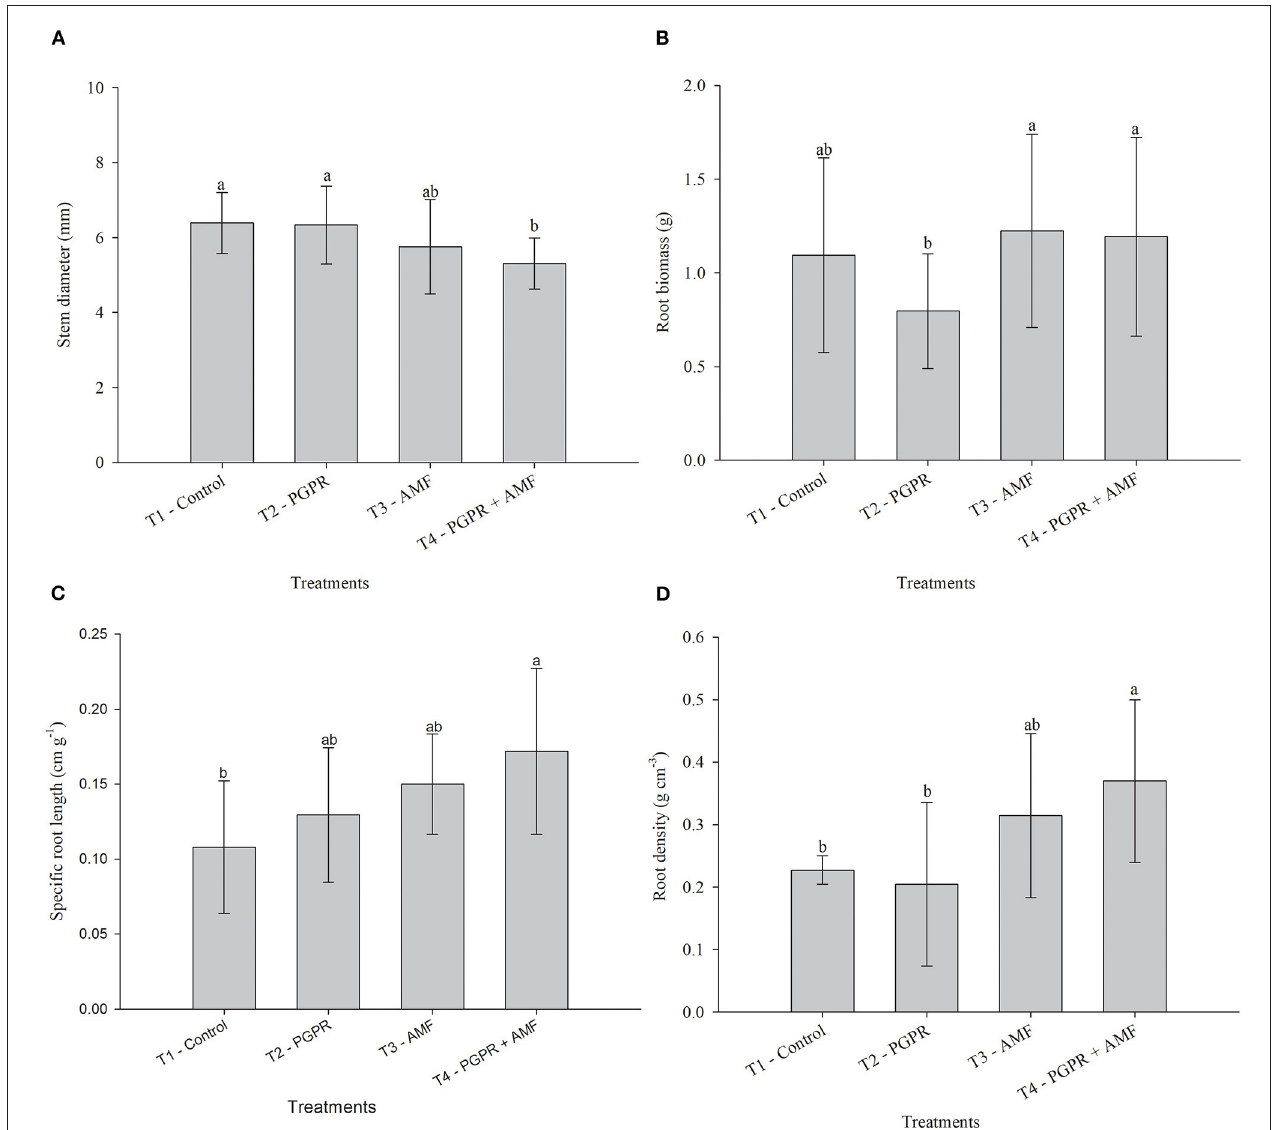
FIGURE 2 | Effect on seedling growth of Tectona grandis at 90 days. (A) Stem diameter. (B) Root biomass. (C) Specific root length. (D) Root density ( n = 20). Bars followed by the same letter do not differ by Turkey test ( p ≤ 0.05). Bars represent standard deviation of means.